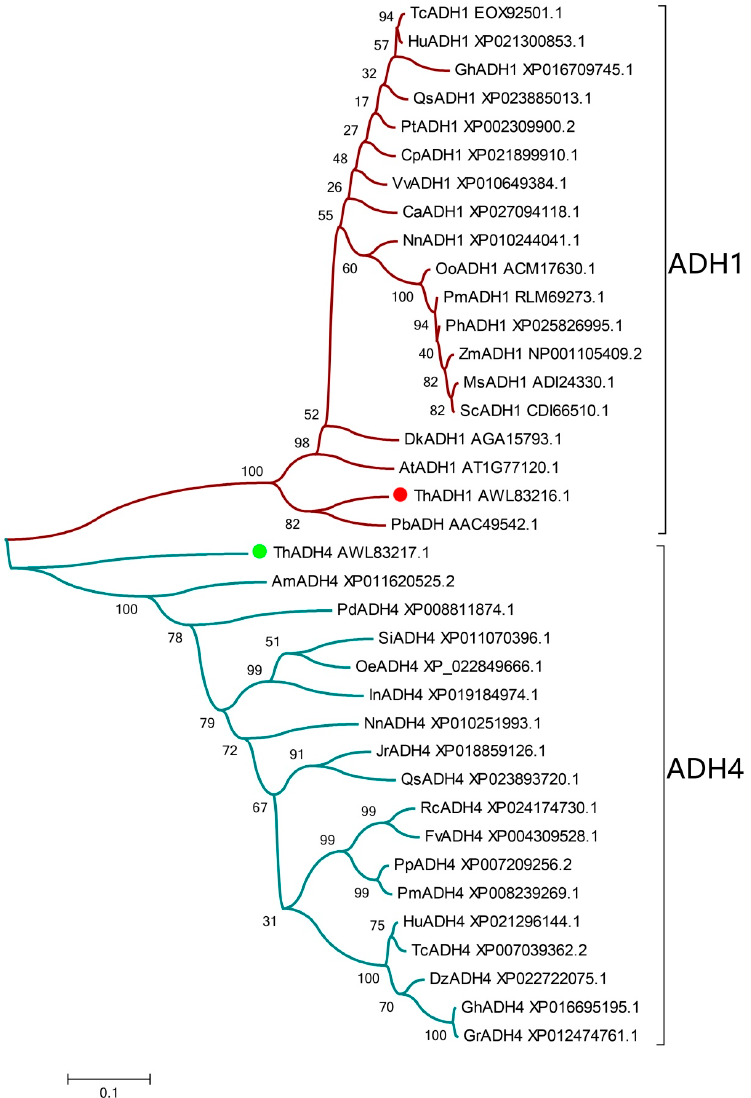
Figure 2. Phylogenetic analysis of the proteins of the ADH gene family. The phylogenetic tree was constructed using MEGA 7.0 with the maximum likelihood method using 1000 replicate bootstrap tests. Numbers near to the nodes indicate bootstrap values obtained from 1000 replications. The 35 proteins were clustered into two distinct groups: ADH1 and ADH4, as indicated. At, Arabidopsis thaliana ; Os, Oryza sativa ; Pb, Pinus banksiana ; Pt, Populus trichocarpa ; Hu, Herrania umbratica ; Tc, Theobroma cacao ; Vv, Vitis vinifera ; Pa, Prunus avium ; Qs, Quercus suber ; Pm, Panicum miliaceum ; Zm, Zea mays ; Dl, Dimocarpus longan ; Rc, Rosa chinensis ; Gh, Gossypium hirsutum ; Ca, Coffea arabica ; Sh, Saccharum hybrid cultivar; Ms, Miscanthus sinensis ; Nn, Nelumbo nucifera ; Dk, Diospyros kaki ; Oo, Oryza officinalis ; Am, Amborella trichopoda ; Nn, Nelumbo nucifera ; Dz, Durio zibethinus ; Gr, Gossypium raimondii ; Rc, Rosa chinensis ; Jr, Juglans regia ; Oe, Olea europaea var. sylvestris ; Pm, Prunus mume ; Pp, Prunus persica ; Pd, Phoenix dactylifera ; In, Ipomoea nil ; Se, Sesamum indicum ; Fv, Fragaria vesca subsp. vesca ; Zm, Zea mays ; Cp, Carica papaya ; Ph, Panicum hallii ; Sc, Saccharum hybrid cultivar; Si, Sesamum indicum